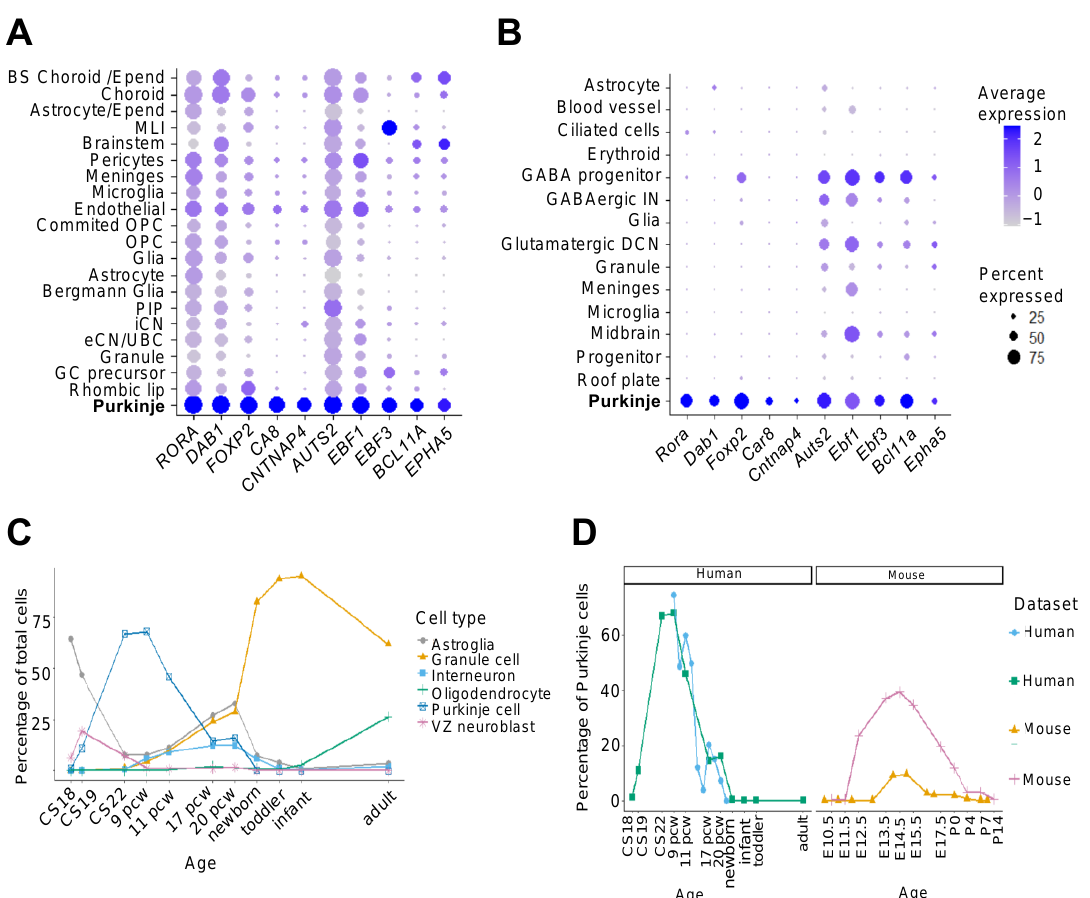
Figure 2. Single-cell transcriptomics of the developing human cerebellum identifies cell type markers and highlights changes in cell populations over time. Expression of Purkinje cell markers is consistent across two transcriptomic datasets. Expression of the top 10 common Purkinje cell markers (Table 2) are shown across cell types in ( A ) Human [26] and ( B ) Mouse [25] developing cerebellar datasets. ( C ) The proportion of different cerebellar cell types changes over the course of human cerebellar development [33]. Only the six cell types with highest frequencies are shown for clarity. ( D ) The developing human cerebellum has an approximately two-fold higher peak percentage of Purkinje cells compared to mouse. This observation is consistent across human (blue circle [26], green square [33]) and mouse (orange triangle [25], pink cross [33]) RNA-seq datasets. BS, brain stem; CS Carnegie stage; DCN, deep cerebellar nuclei; E, embryonic day; eCN, excitatory cerebellar interneurons; Epend, Ependymal; iCN, inhibitory cerebellar nuclei; IN, interneuron; MLI, molecular layer interneurons; OPC, oligodendrocyte progenitor cells; P, postnatal day; pcw, post conception week; PIP, PAX2+ interneuron progenitors; UBC, unipolar brush cell; VZ, ventricular zone.